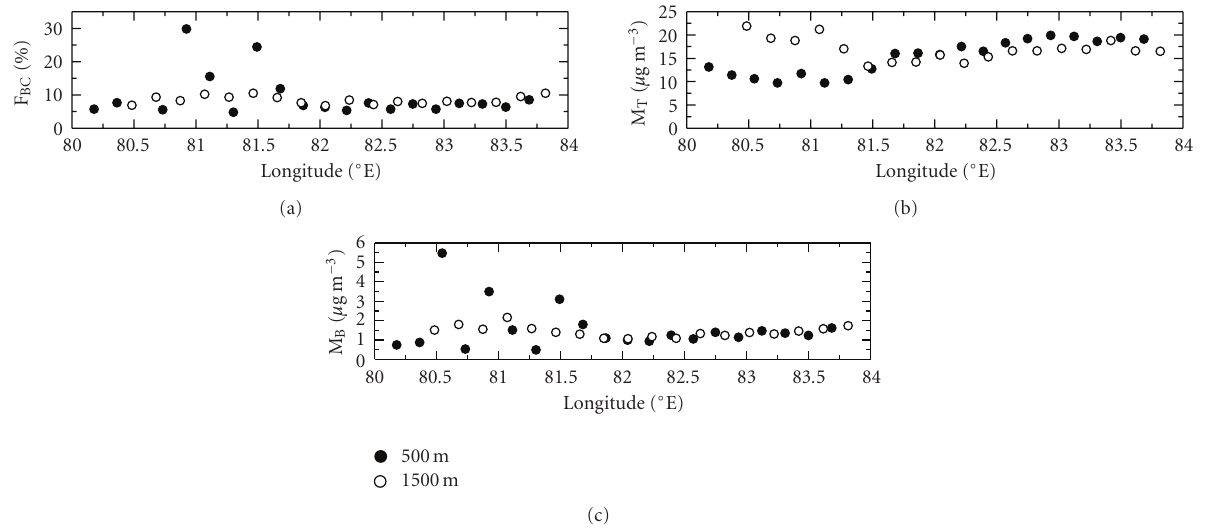
Figure 4: Longitudinal variation of M B , M T , and F BC at 500 m and 1500